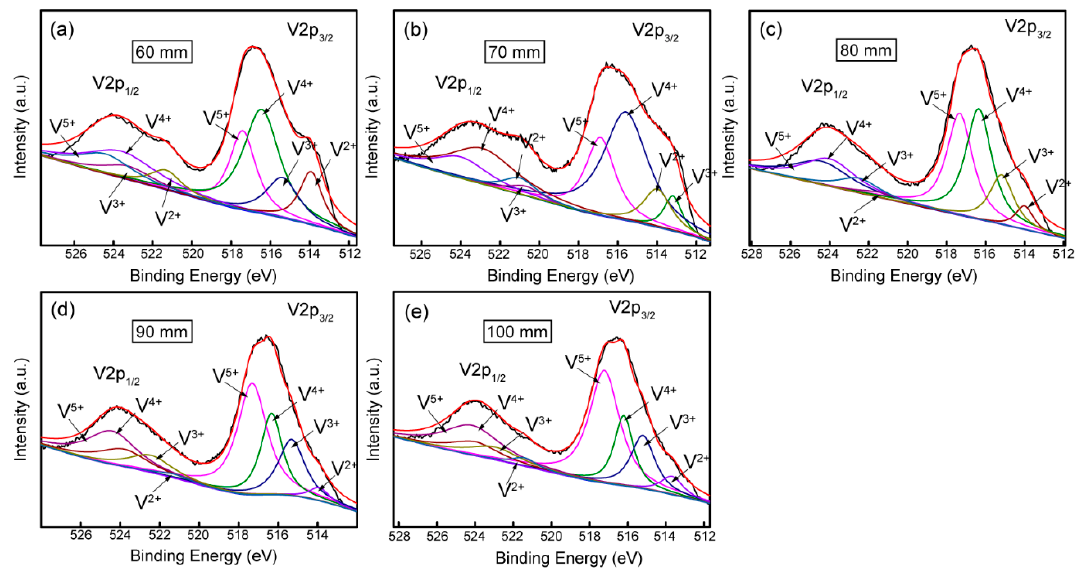
Figure 12. Effects of substrate temperatures ( T s ) on the area ratio ( r ) of the peaks of V films on Si (100).